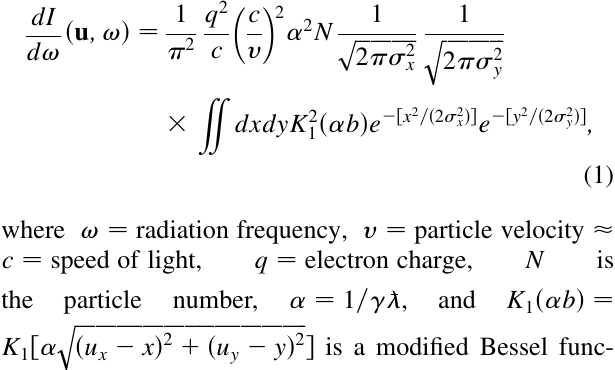
FIG. 3. A comparison of the calculated projected OSR from the upstream dipole with a beam bending radius of 25 m and the ODR intensities at the OTR/ODR screen.